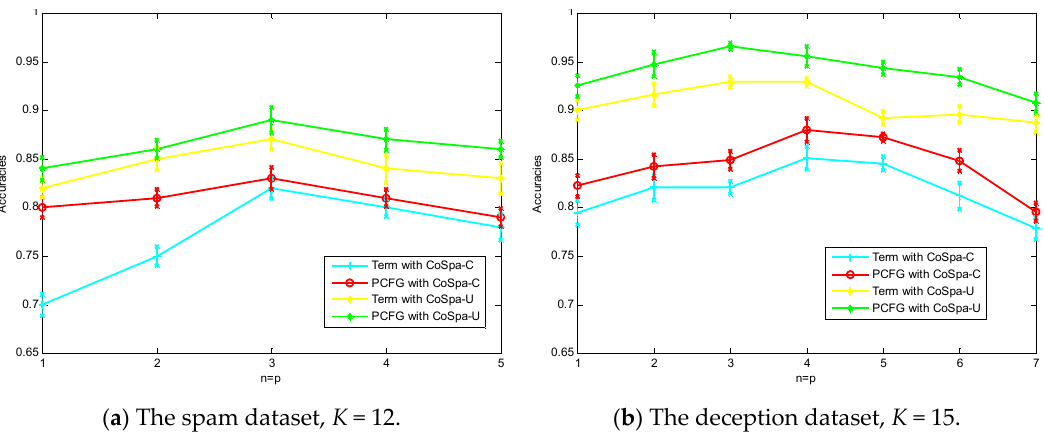
Figure 3. Performance of the CoSpa algorithm with different n = p compared with different strategies. Table 8. The performance accuracies of the CoSpa algorithm with different strategies for selecting classified unlabeled